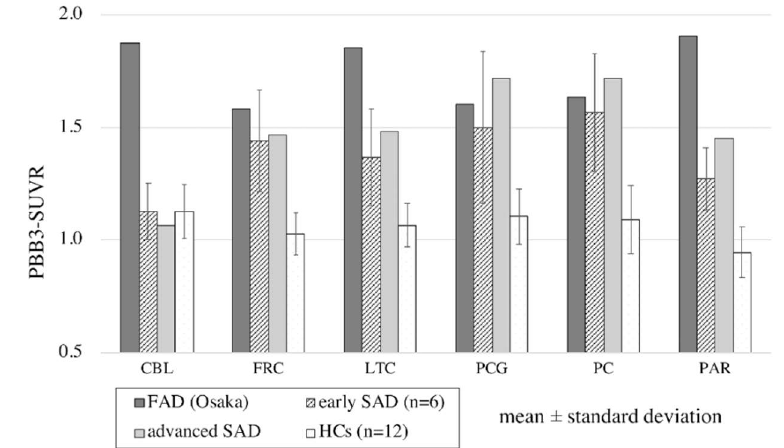
Figure 3. Regional PBB3 uptake with reference to the midbrain in familial Alzheimer’s disease with Osaka mutation (FAD (Osaka)), in early and advanced stage patients with sporadic Alzheimer’s disease (SAD) and healthy controls (HCs). Regions were set in the cerebellum (CBL), frontal cortex (FRC), lateral temporal cortex (LTC), posterior cingulate gyrus (PCG), precuneus (PC) and parietal cortex (PAR). In the cerebral cortex, PBB3 uptake in the FAD (Osaka) patient was higher than that in the HCs in all regions (>2.5 SD). PBB3 uptake was even higher than that in the early stage SAD patients and advanced stage SAD patients in the lateral temporal (>2 SD) and parietal cortices (>2.5 SD). Remarkably elevated PBB3 uptake in the cerebellum was found only in the FAD (Osaka) patient.